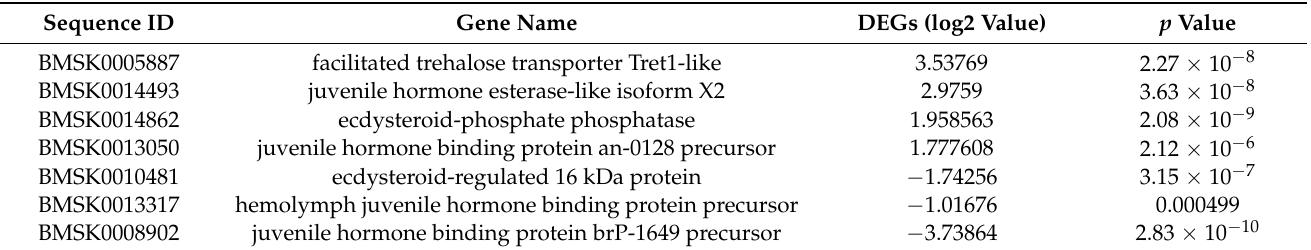
Table 3. Summary of development-related DEGs induced by E. japonica